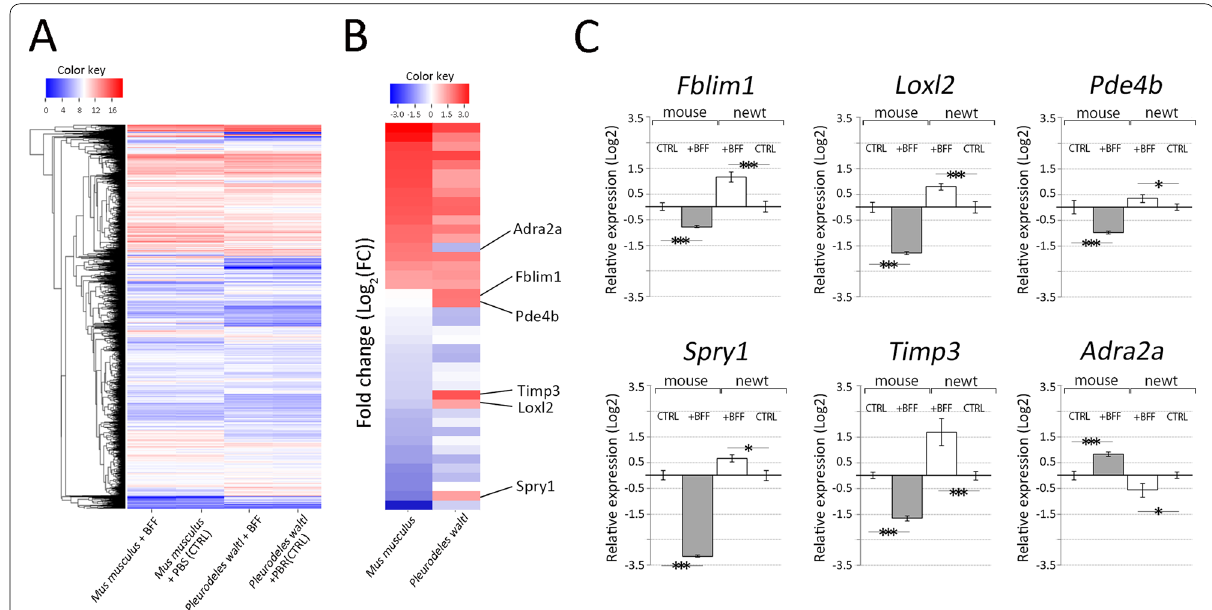
Fig. 3 Selection of genes responding to B2FF in cell culture. A Z-score obtained via CAGE-seq is visualized as the heatmap. The samples are mouse dermal fibroblasts with B2FF application, mouse dermal fibroblasts without B2FF application (CTRL), newt dermal fibroblasts with B2FF application, and newt dermal fibroblasts without B2FF application (CTRL) from the left. B the heatmap of the selected genes, which were up/down-regulated by B2FF application. C the gene expression pattern was confirmed by the quantitative RT-PCR. Genes, which were oppositely responded to B2FF in mouse and newt cells, were selected and confirmed. * p < 0.05. *** p <